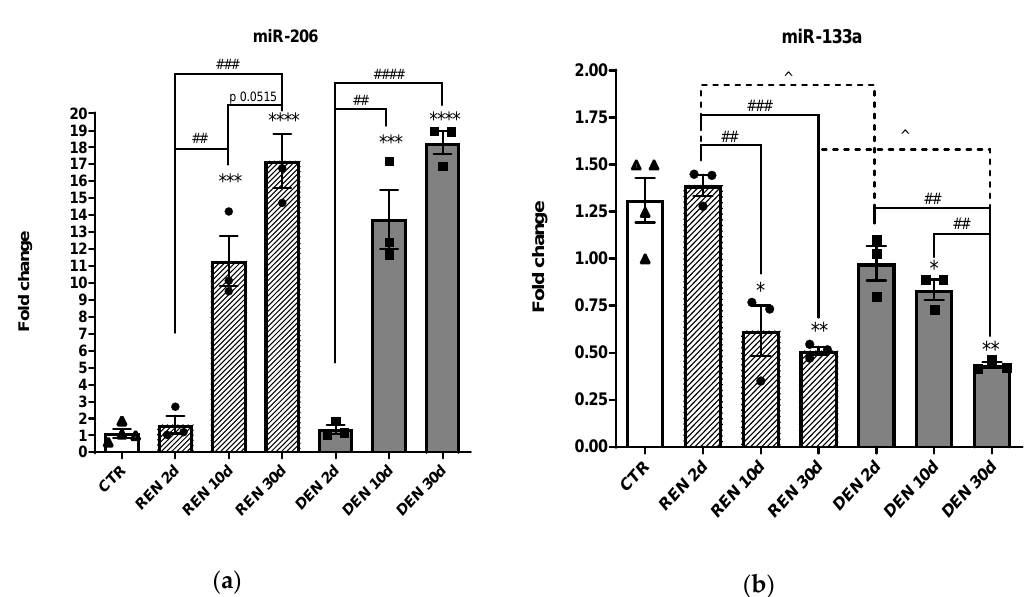
Figure 1. Muscle expression of miR-206 and miR-133a during muscle denervation and re-innervation. RT-PCR of ( a ) miR-206, ( b ) miR-133a in re-innervating (REN) and chronic denervated gastrocnemius muscles (DEN), 2 days (2d), 10 days (10 d) and 30 days (30 d) after sciatic nerve resection (* comparison vs. control: (* p < 0.05, ** p < 0.005, *** p < 0.0005, **** p < 0.0001. ˆ and # comparison between groups ˆ p < 0.05, ## p < 0.005, ### p < 0.0005, #### p < 0.0001. • , ▲ , ■ represent samples in control, re-innervating and denervated groups).